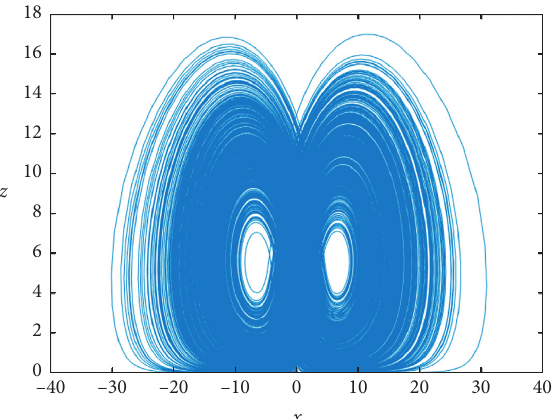
Figure 11: Dynamics of Lu et al.’s fractional-order system in (13)–(15) with the order α � 0 . 88, in context of x and z directions.